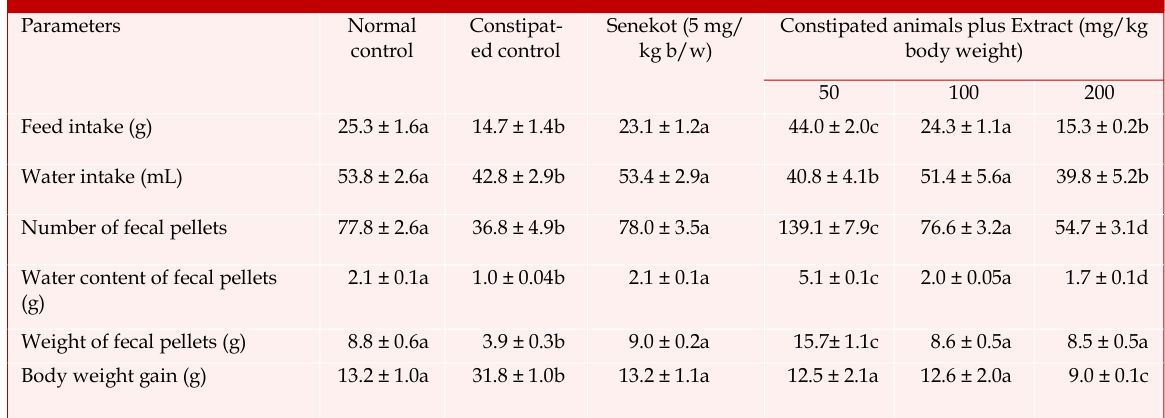
Effect of ethanolic seed extract of C. penduliflorus on some indices of constipation